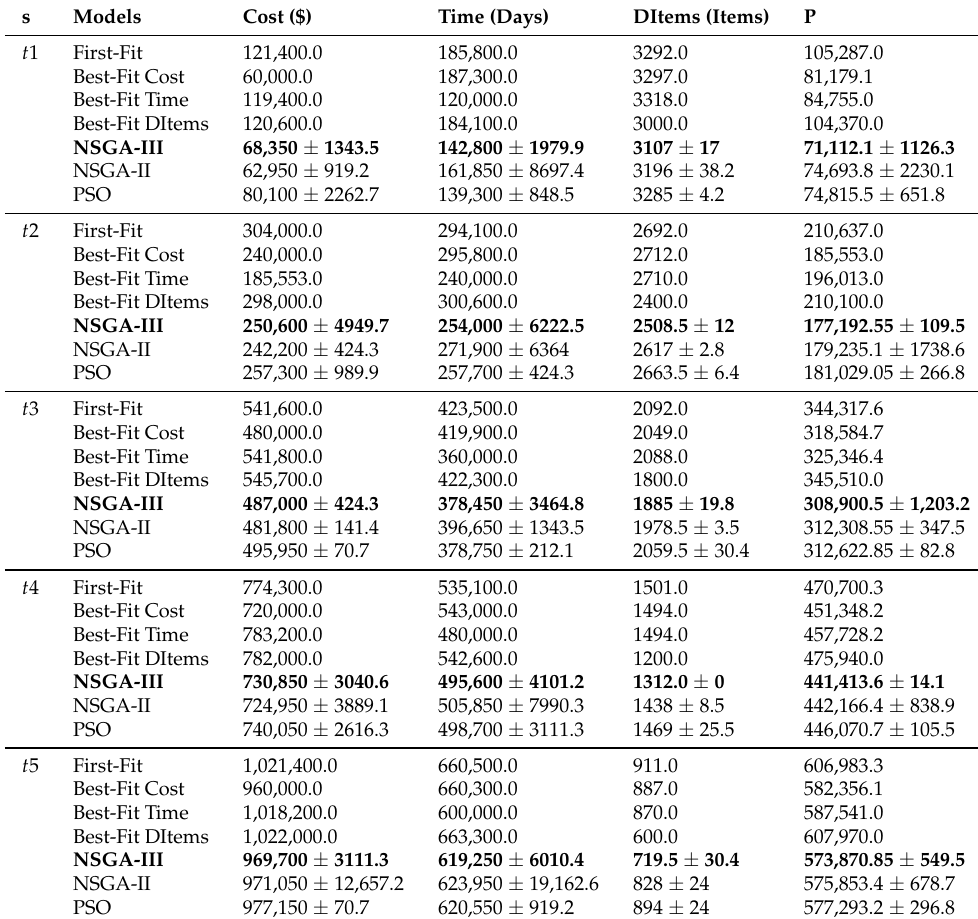
Table 4. The performance of NSGA-III vs. comparative